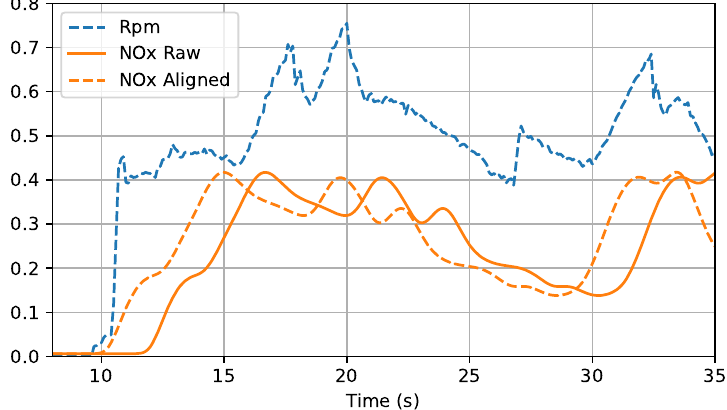
Figure 5. Synchronization of NOx signal with engine firing, using engine rotational speed as